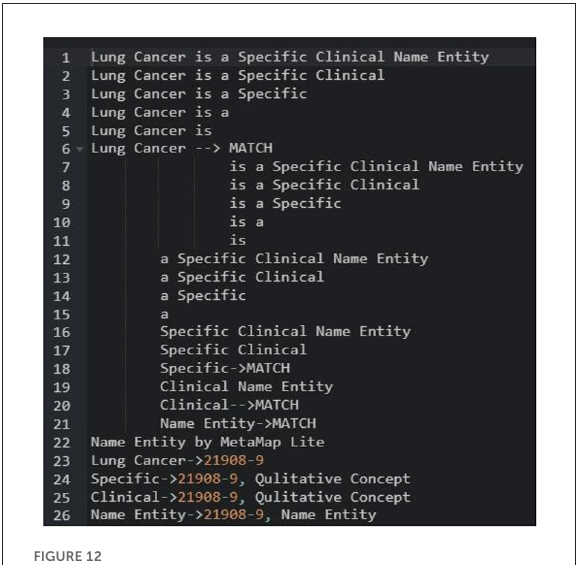
FIGURE12 Test finding of UMLS-based